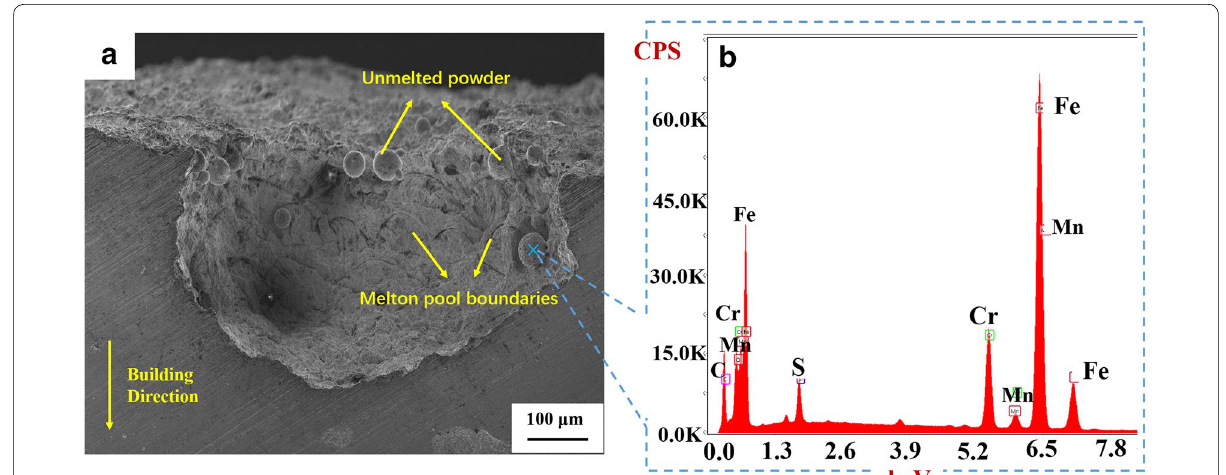
Figure 9 a Corrosion morphology of the cross‑section of as‑SLM sample; b EDS point analysis indicates the existing un‑melted powder